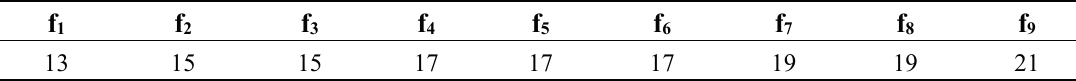
Table 1. Number of beams vs.